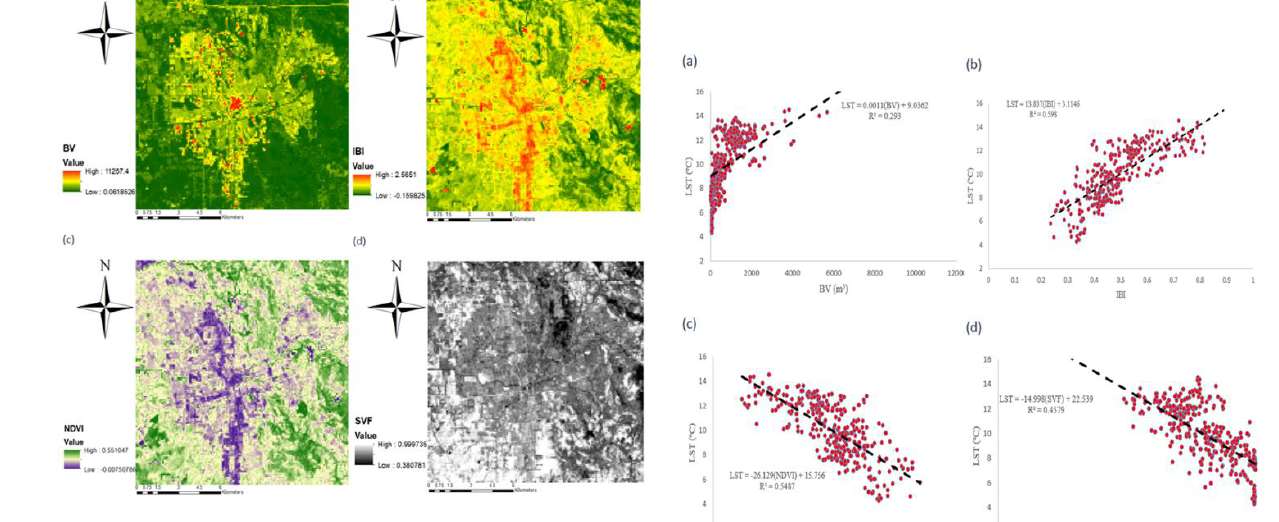
Figure 4. Average LST of the study area